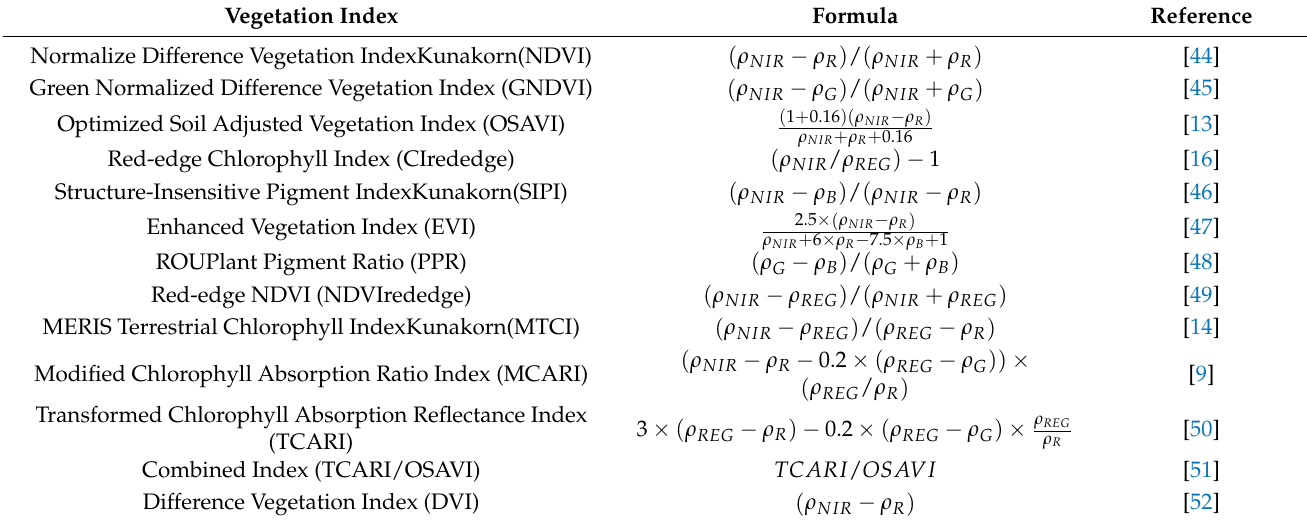
Table 1. The VIs used in this